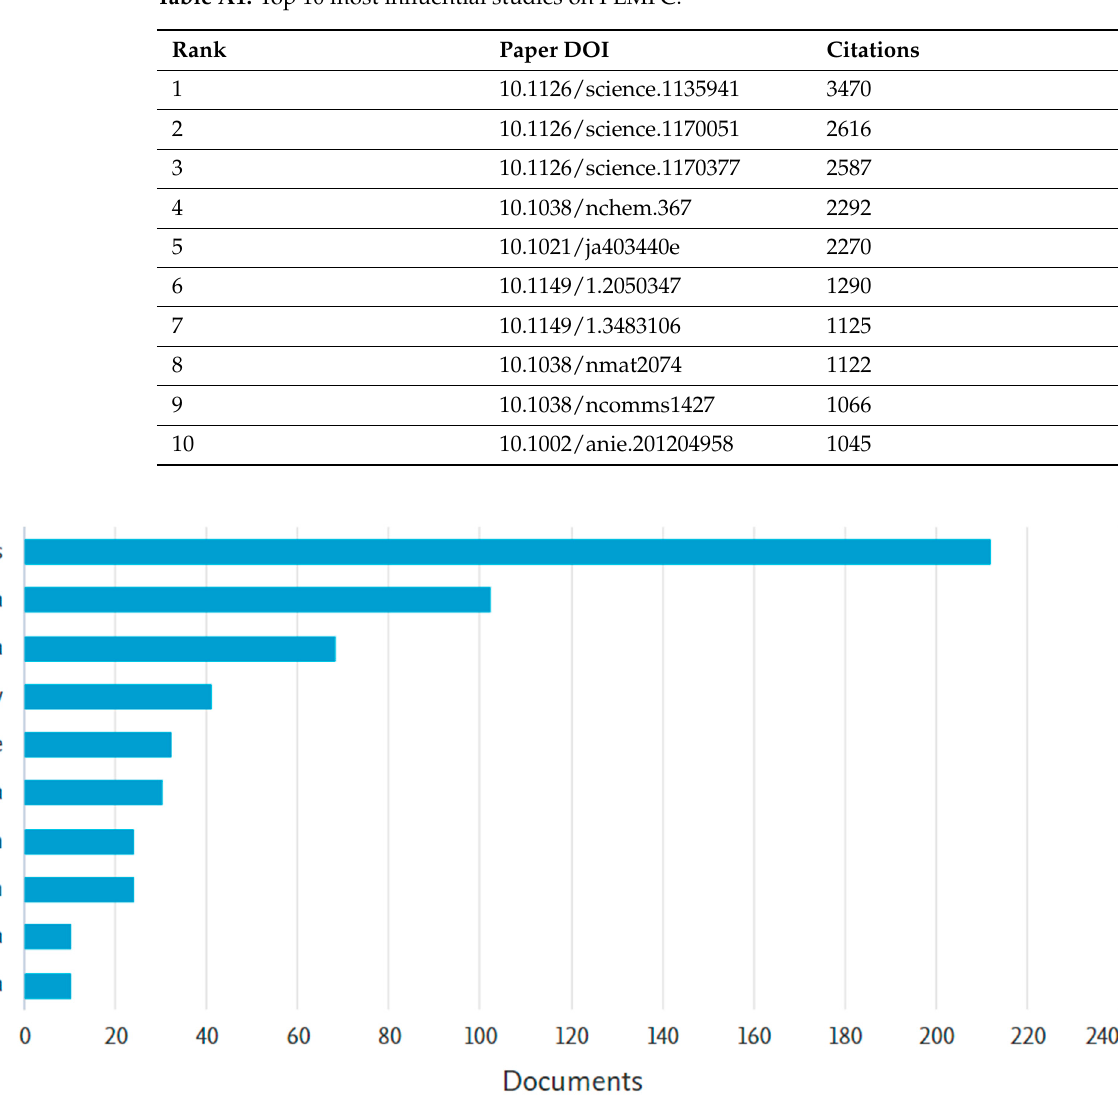
Figure A1. Most productive countries according to the 500 most cited documents in the PEMFC research field.